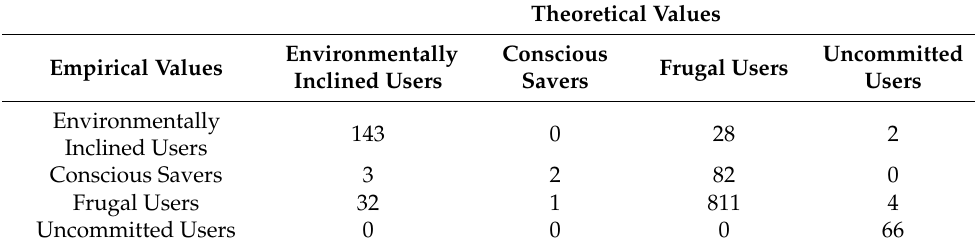
Table 3. Classification